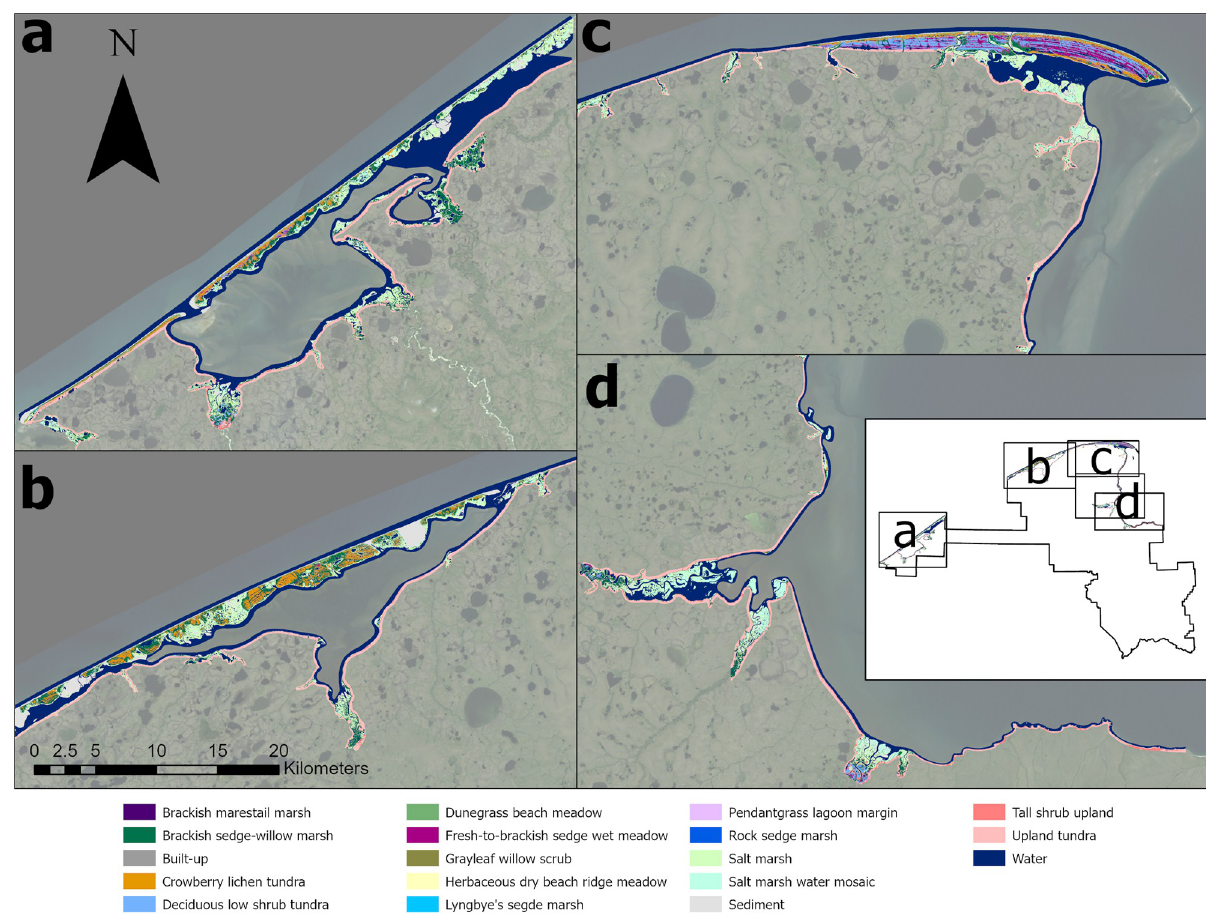
Fig 8. Map of coastal vegetation of Bering Land Bridge National Preserve. Background imagery Landsat mosaic produced for the Arctic Network. https://irma.nps.gov/DataStore/Reference/Profile/2171608 Public domain.